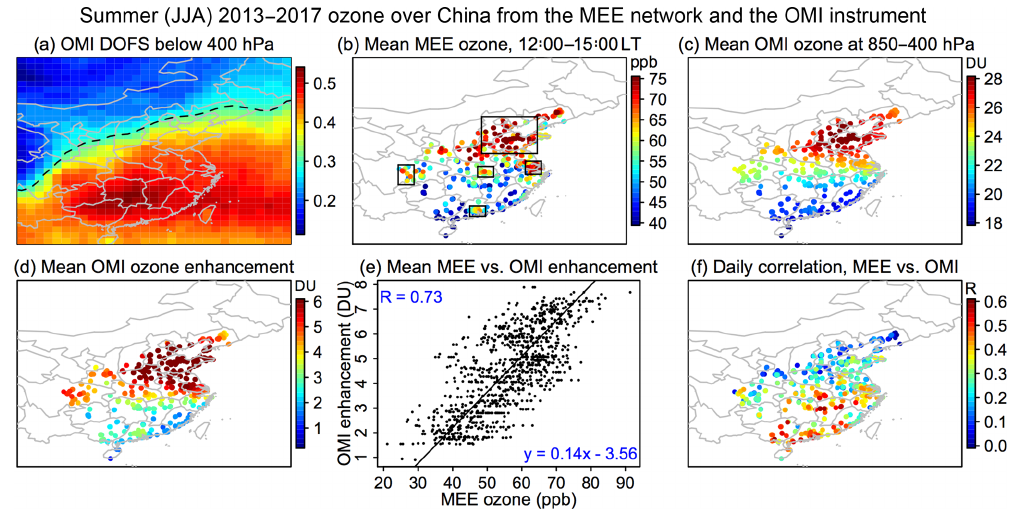
Figure 1. Summertime observations of ozone over China (JJA 2013–2017) from the MEE surface network and the OMI satellite instrument. (a) Mean degrees of freedom for signal (DOFS) of OMI ozone retrievals below 400hPa. We limit our attention to the China domain with DOFS > 0.3 (south of dashed line) and to sites with at least 100 concurrent surface and OMI observations for the 2013–2017 period. (b) Mean midday (12:00–15:00 local time) ozone concentrations from the MEE surface network. Rectangles identify high-ozone regions discussed in the text including Beijing–Tianjin–Hebei (BTH, 114–121 ◦ E and 34–41 ◦ E), Yangtze River Delta (YRD, 119.5–121.5 ◦ E and 30–32.5 ◦ E), Pearl River Delta (PRD, 112.5–114.5 ◦ E and 22–24 ◦ E), Sichuan Basin (SCB, 103.5–105.5 ◦ E and 28–31.5 ◦ E) and Wuhan (113.5–115.5 ◦ E and 29.5–31.5 ◦ E). (c) Mean OMI partial columns at 850–400hPa. (d) Mean OMI ozone enhancements at 850–400hPa after subtraction of the latitude-dependent mean background over the Pacific (150 ◦ E–150 ◦ W). (e) Spatial correlation of mean JJA 2013–2017 MEE ozone with the OMI ozone enhancement at 850–400hPa. The correlation coefficient and the fitted reduced-major-axis (RMA) regression equation are shown inset. (f) Temporal correlation coefficients ( R ) of daily MEE surface ozone with OMI at individual sites, measuring the ability of OMI to capture the day-to-day variability of surface